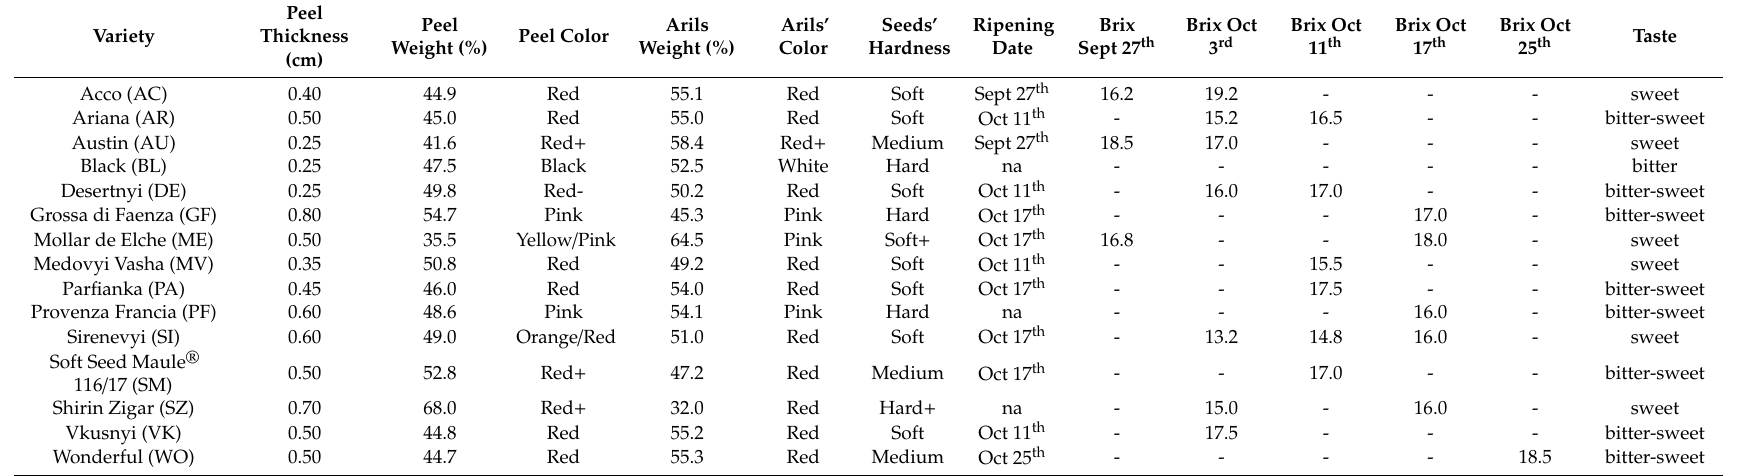
Table 1. Characteristics of the fruit samples provided by the producer. na: not available; peel means exocarp + mesocarp; Sept, September; Oct, October. Variety